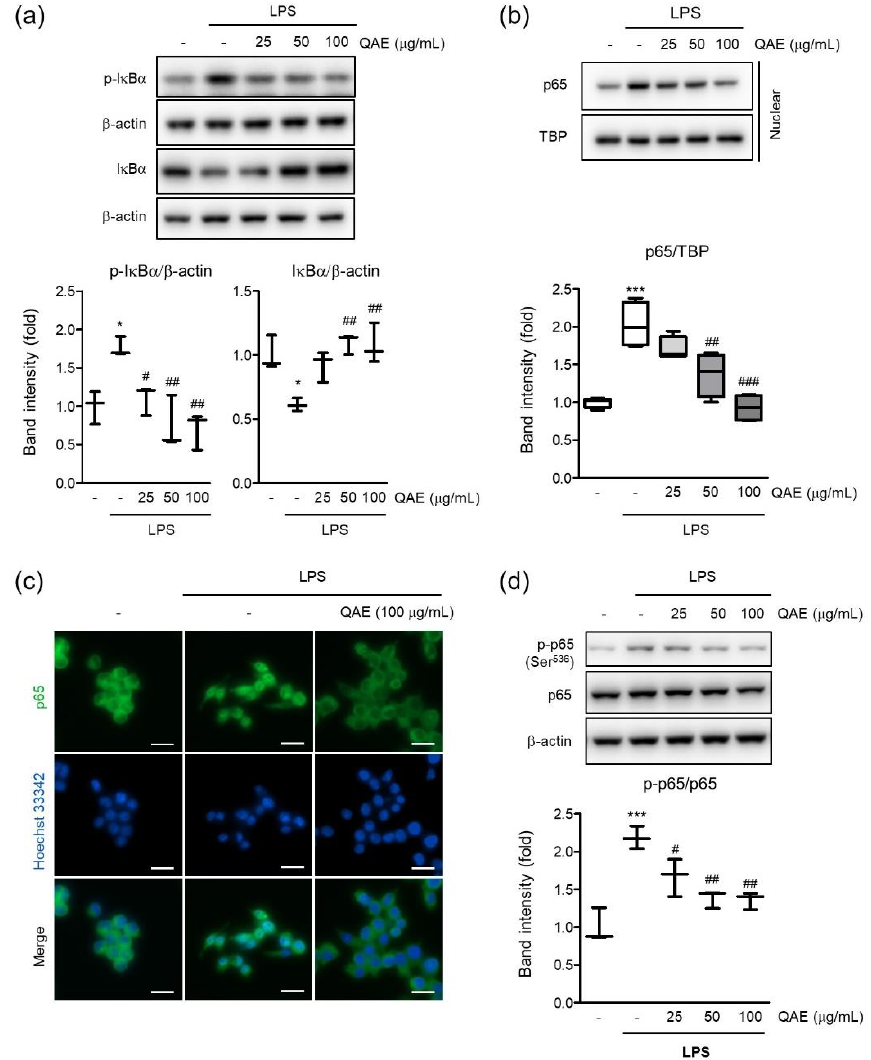
Figure 4. QAE inhibits the nuclear factor- κ B (NF- κ B) signaling pathway in LPS-stimulated BV2 microglial cells. After QAE pretreatment (25–100 µ g/mL) for 3 h, BV2 microglial cells were exposed to LPS (100 ng/mL) for 1 h. ( a ) Phosphorylation and degradation of I κ B α . Equal protein loading was verified by β -actin immunoblotting ( n = 3). ( b ) p65 expression in nuclear. Equal nuclear protein loading was verified by TATA-box binding protein (TBP) immunoblot ( n = 4). ( c ) Immunocytochem- istry. After treatment, cells were immunostained with an anti-NF- κ B (p65) antibody and Alexa Fluor 488-conjugated secondary antibody. Scale bar represents 25 µ m. Hoechst 33342 was used for nuclear counterstaining ( n = 3). ( d ) Phosphorylation of p65 at Ser 536 . Expression of phosphorylated p65 was normalized with expression of total p65 immunoblotting ( n = 3). Significant versus control, * p < 0.05, *** p < 0.001; Significant versus LPS alone-treated group, # p < 0.05, ## p < 0.01, ### p < 0.001.